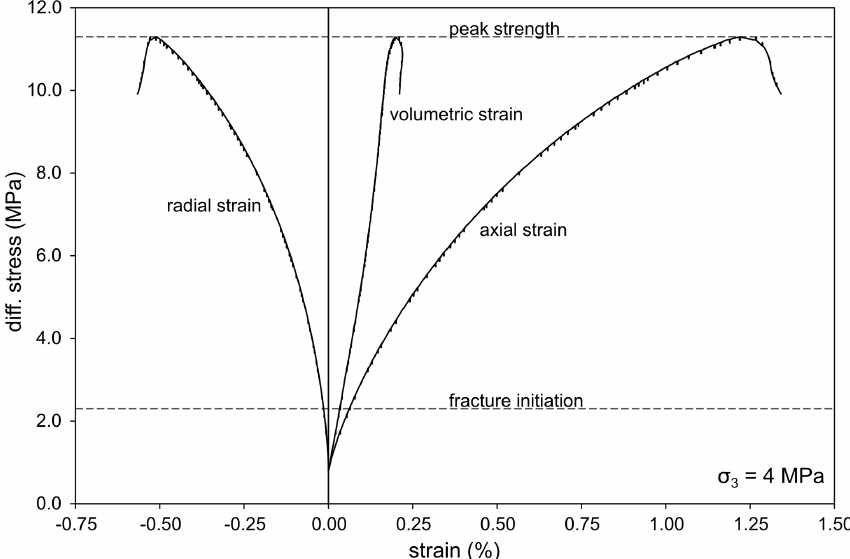
Figure 1. Stress versus strain development during the shearing phase. The shearing was conducted circumferential-displacement-controlled (0.08mmmin − 1 ) and at constant confining stress of 4MPa. Peak stress was reached at 11.3MPa differential stress, and fracture (see Amann et al., 2012) initiation was observed at 2.3MPa. The volumetric strain curve corresponds to bulk compaction over the entire